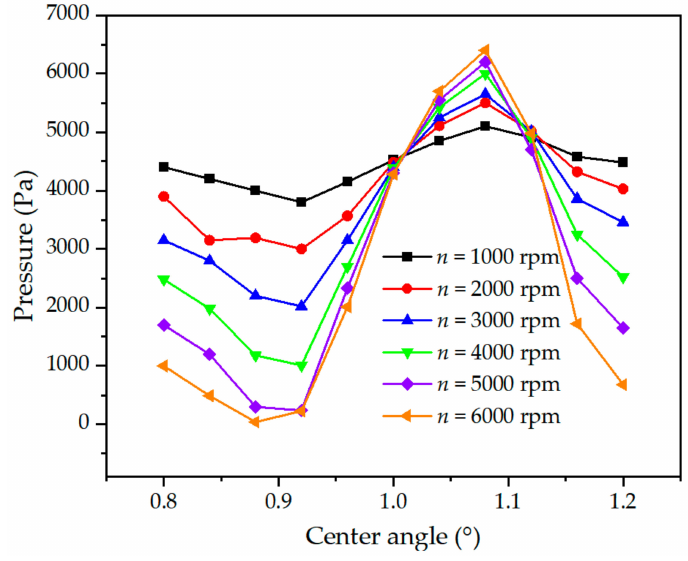
Figure 27. Pressure distribution in texture dimple with cavitation effect at different rotational speeds.